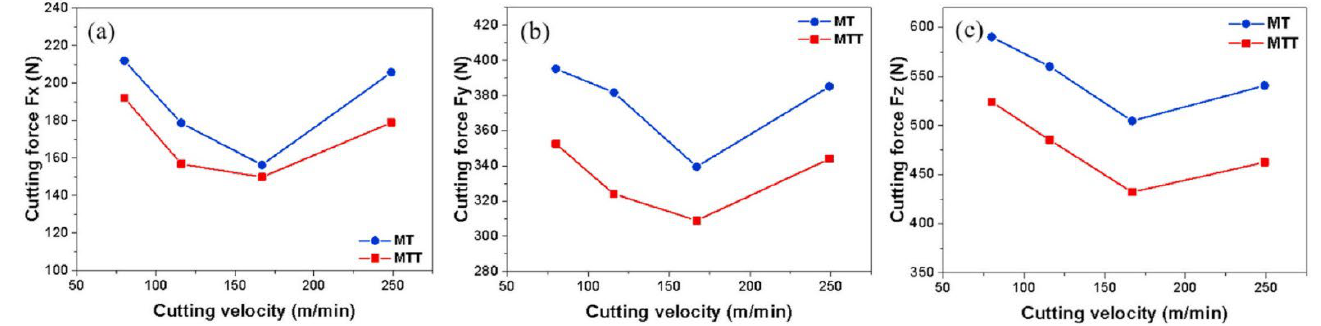
Figure 24. Cutting forces of the MTs and MTTs: ( a ) axial thrust force F x ; ( b ) radial thrust force F y ; ( c ) main cutting force F z [76] .